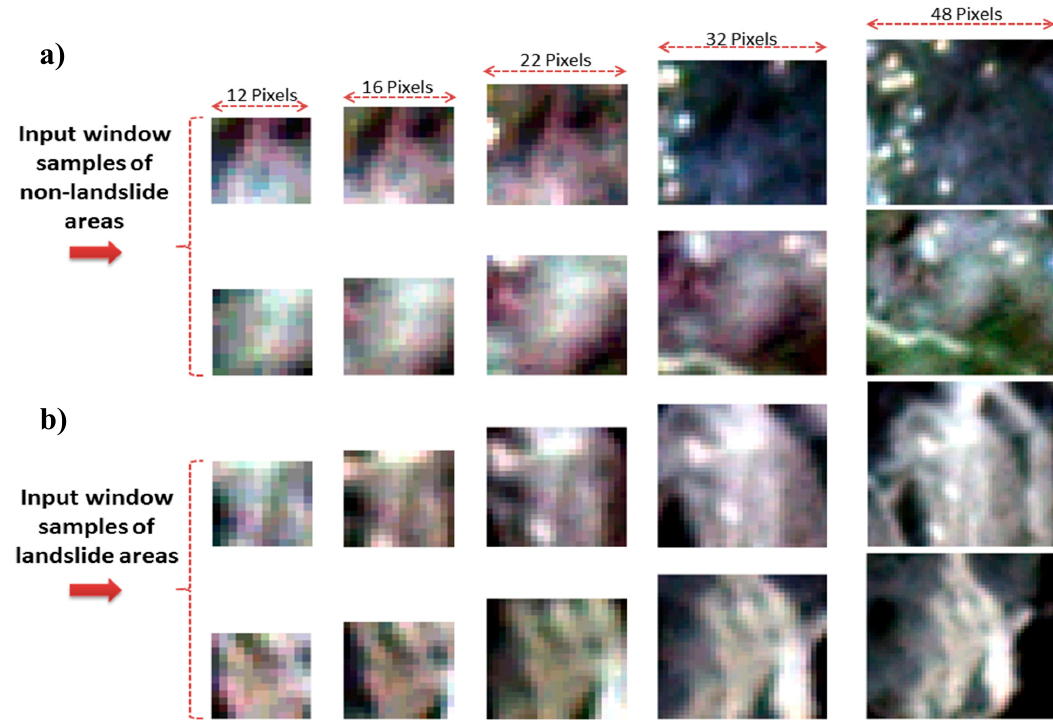
Figure 6. An illustration of convolution input window sizes from ( a ) two non-landslide areas and ( b ) two landslide areas.